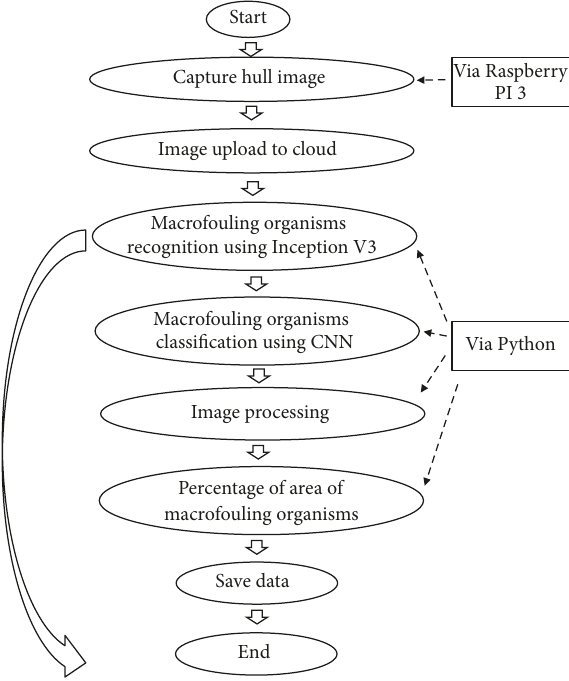
Figure 2: Software program